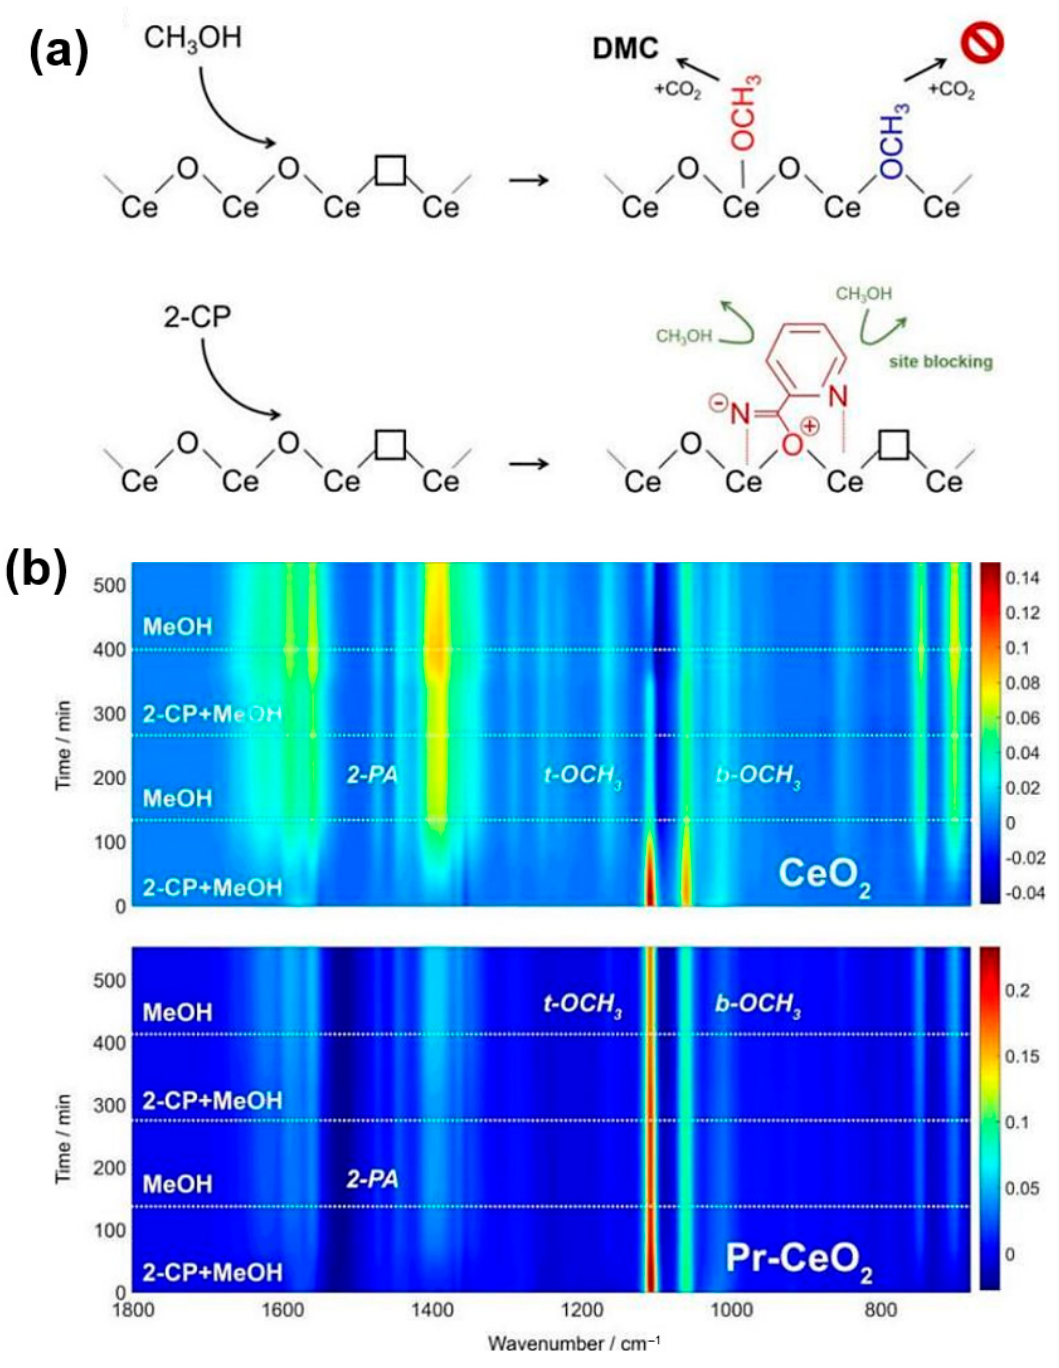
Figure 5. ( a ) Simplified DMC formation over CeO 2 by the coupling between t-OCH 3 and CO 2 with the aid of 2-CP. The hydrolysis of 2-CP on the CeO 2 surface causes blocking of the sites for MeOH adsorption. ( b ) In situ ATR-IR spectra of the formed species by alternatingly passing the MeOH vapor and mixed MeOH + 2-CP vapor over CeO 2 and Pr-CeO 2 at 120 ◦ C. Reproduced with permission from Ref. [13]. Copyright 2018 American Chemical Society.